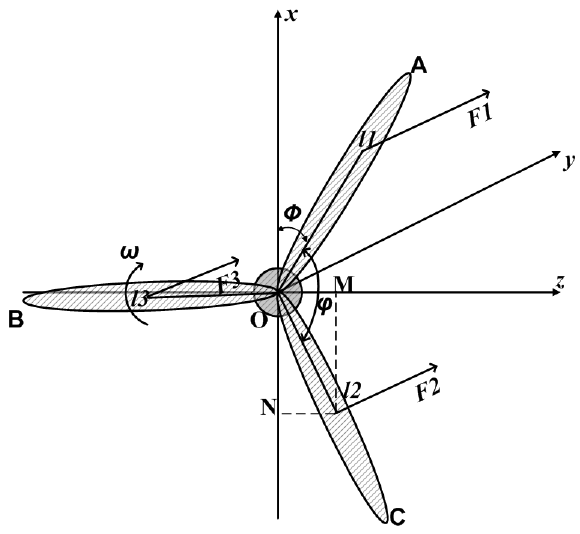
Figure 5 . Thrust force on Wind Turbine.